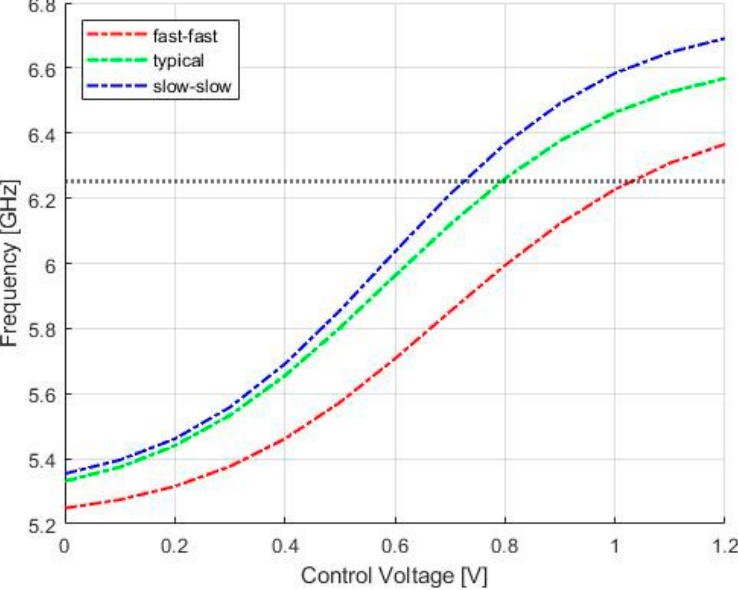
Figure 9. LC-tank VCO post-layout simulation of the free-running frequency versus control voltage in fast-fast ( red line ), typical ( green line ), and slow-slow ( blue line ) technology corner cases. The horizontal marker indicates the target frequency.